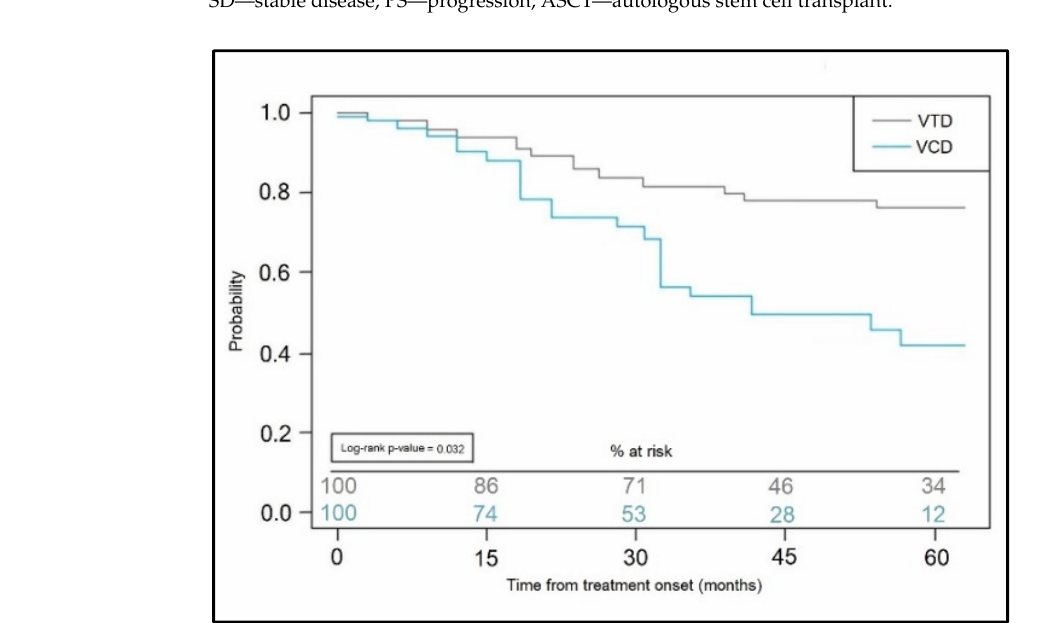
Figure 2. Kaplan-Meyer probability curve of progression-free survival stratified by induction treat- ment scheme.